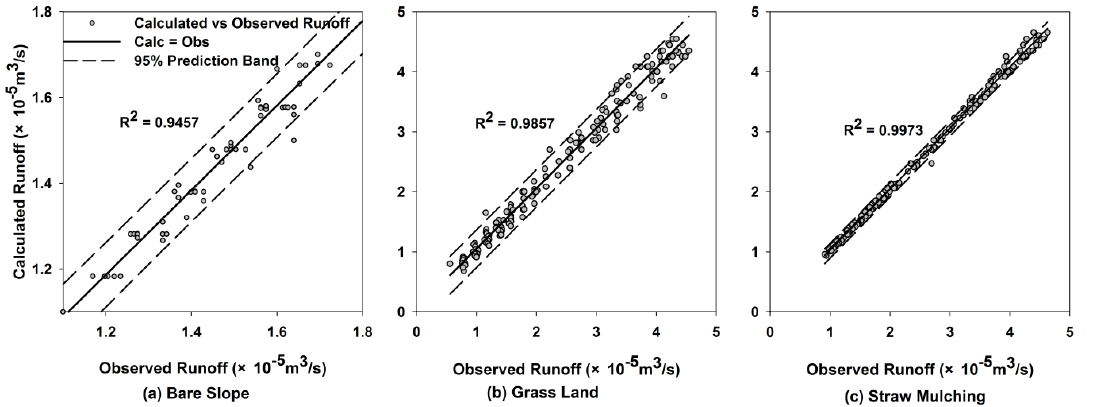
Figure 8. The scatter graph of the calculated vs. observed groundwater runoff for three scenario: ( a ) Bare Slope; ( b ) Grass Land; ( c ) Straw